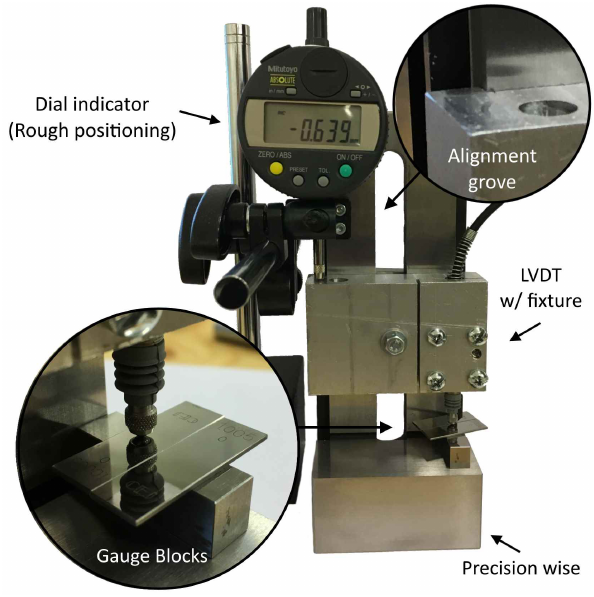
Figure 1: LVDT calibration setup used to measure rel- ative thickness difference of gauge